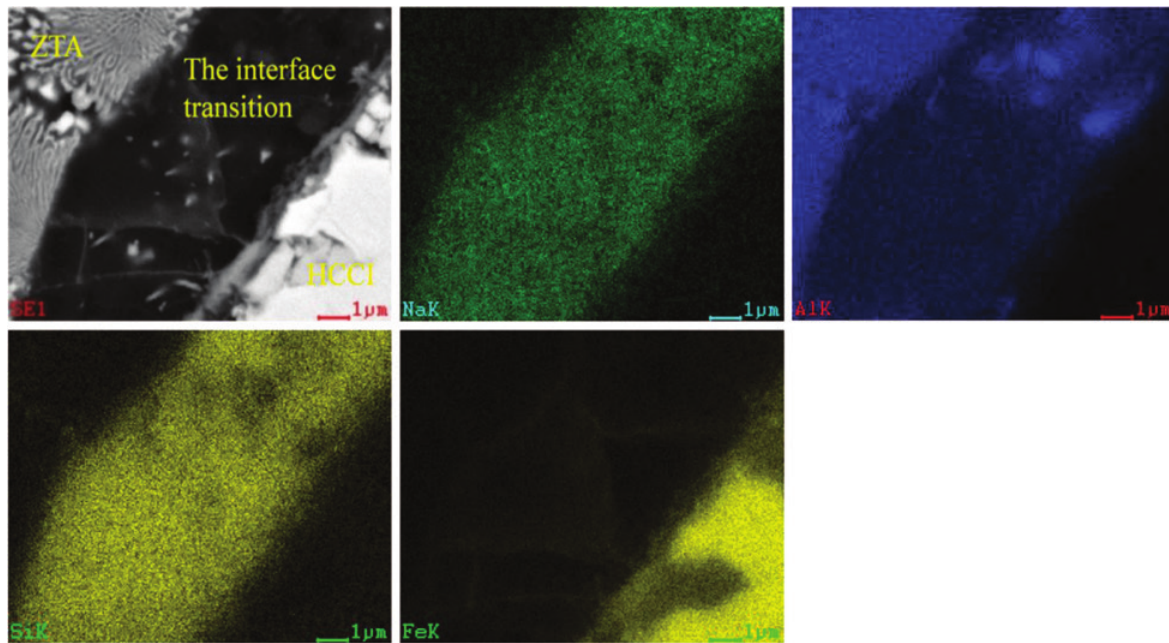
Figure 7: Interface plane energy spectrum of the composite.